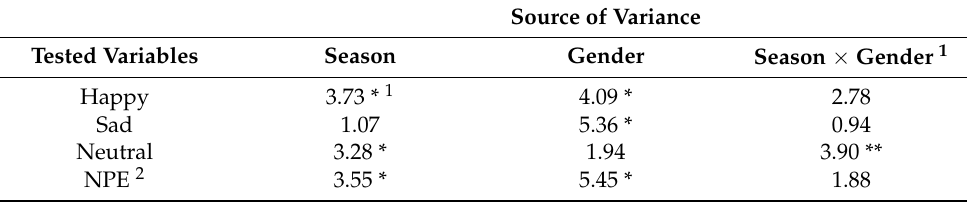
Table 2. F values from mixed-model analysis of variance (ANOVA) of seasonal variation (Season), gender, and their interaction (Season × Gender) on facial expression scores of community inhabitants in Nanchang. Source of Variance Tested Variables Season Gender Season × Gender 1 Happy 3.73 * 1 4.09 * 2.78 Sad 1.07 5.36 * 0.94 Neutral 3.28 * 1.94 3.90 ** NPE 2 3.55 * 5.45 *